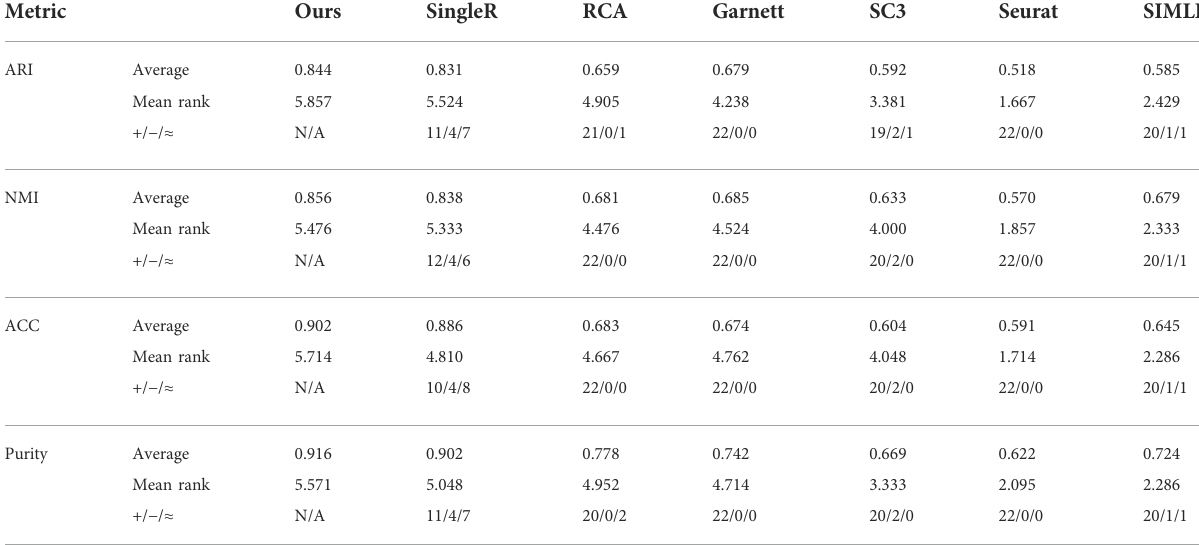
TABLE 3 Clustering results of LFSC and baseline methods on real scRNA-seq datasets.